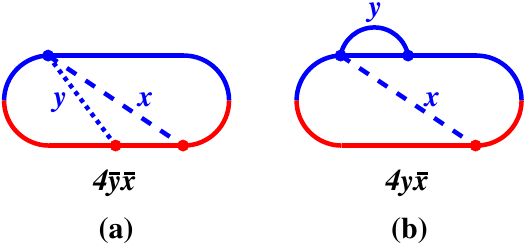
Figure 3 . Two examples of interference contributions involving a fundamental 4-gluon vertex: (a) example of double splitting contributions g → ggg calculated in ref. [16], and (b) example of a corresponding virtual diagram to be computed in this